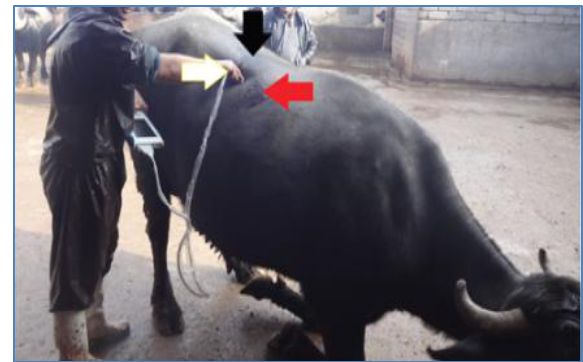
Figure, 1: Sites for ultrasonographic percutaneous examination of right and left kidneys in buffaloes, right sublumbar fossa (white arrow), right 12 th intercostal space (red arrow), right lumbar region (black arrow).